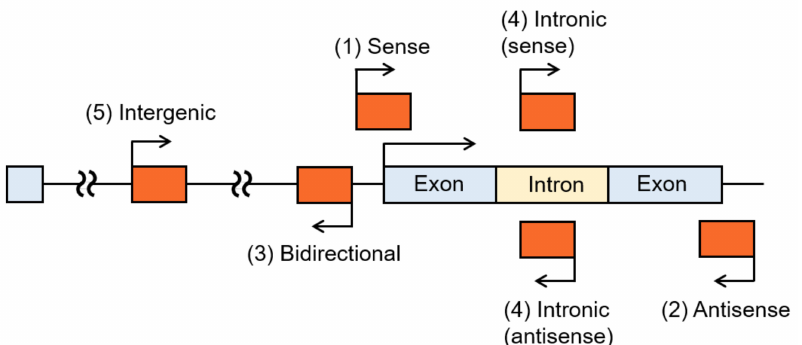
Figure 1. Classification of long noncoding RNAs (lncRNAs). Based on the positions of their loci on the genome, lncRNAs are classified into one or more of five categories: (A) sense, (B) antisense, (C) bidirectional, (D) intronic, and (E)